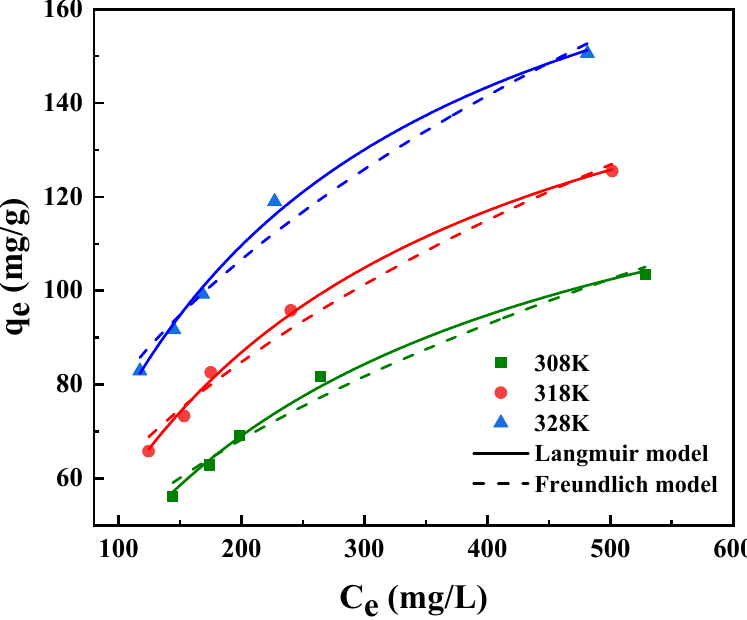
Figure 6. Adsorption thermodynamics for CPCA of PS − DEA − 5 at different temperatures. Table 3. Adsorption isotherms parameters of CPCA on PS − DEA − 5.